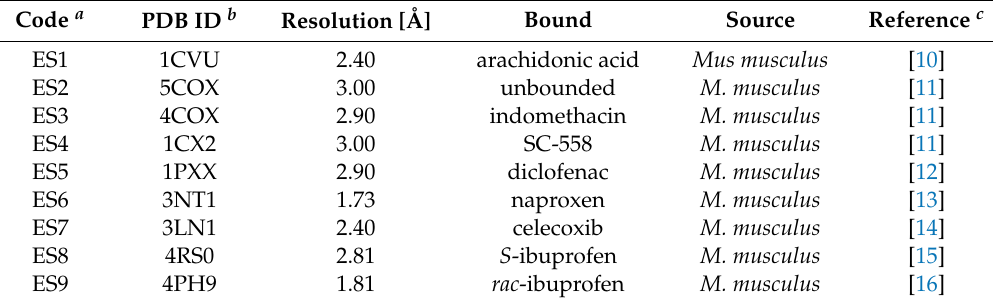
Table 1. Data of the crystal structures of